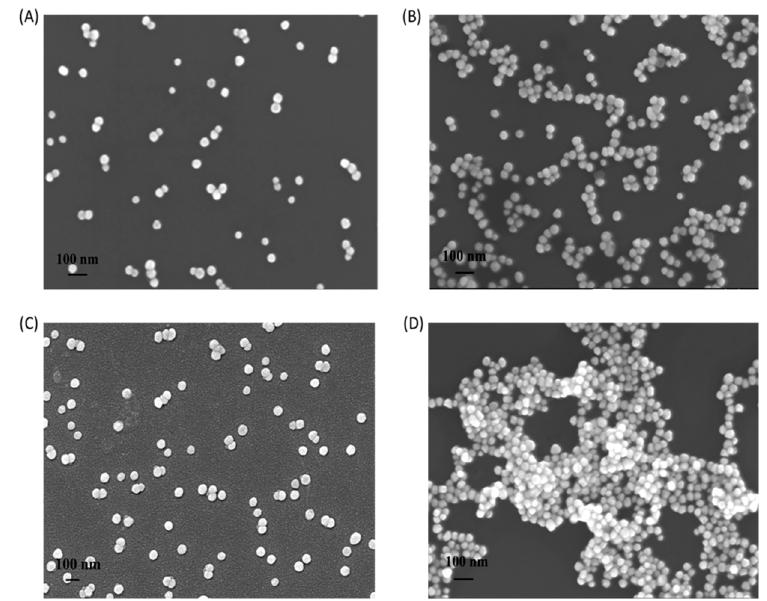
Figure 1. SEM images of different AuNPs ( A ): unconcentrated colloidal AuNPs; ( B ): 2× concentrated colloidal AuNPs; ( C ): NaCl-modified AuNPs; ( D ): NaCl-modified AuNPs with flumetsulam under the addition of MgSO 4 ).